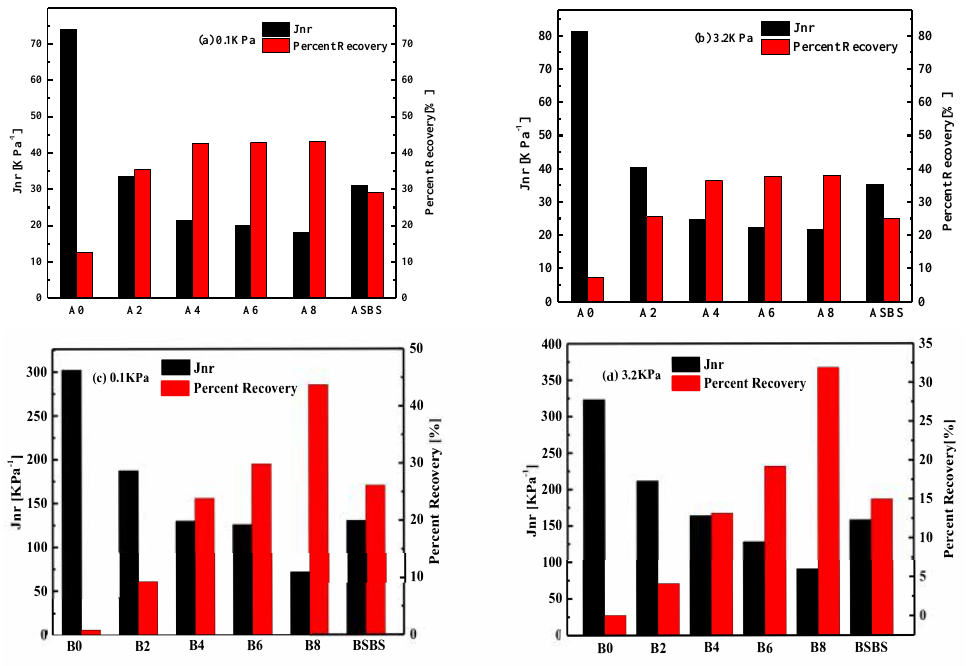
Figure 8. E ff ects of SBS latex content on the percent recovery (R%) and non-recovery compliance (Jnr) of modified